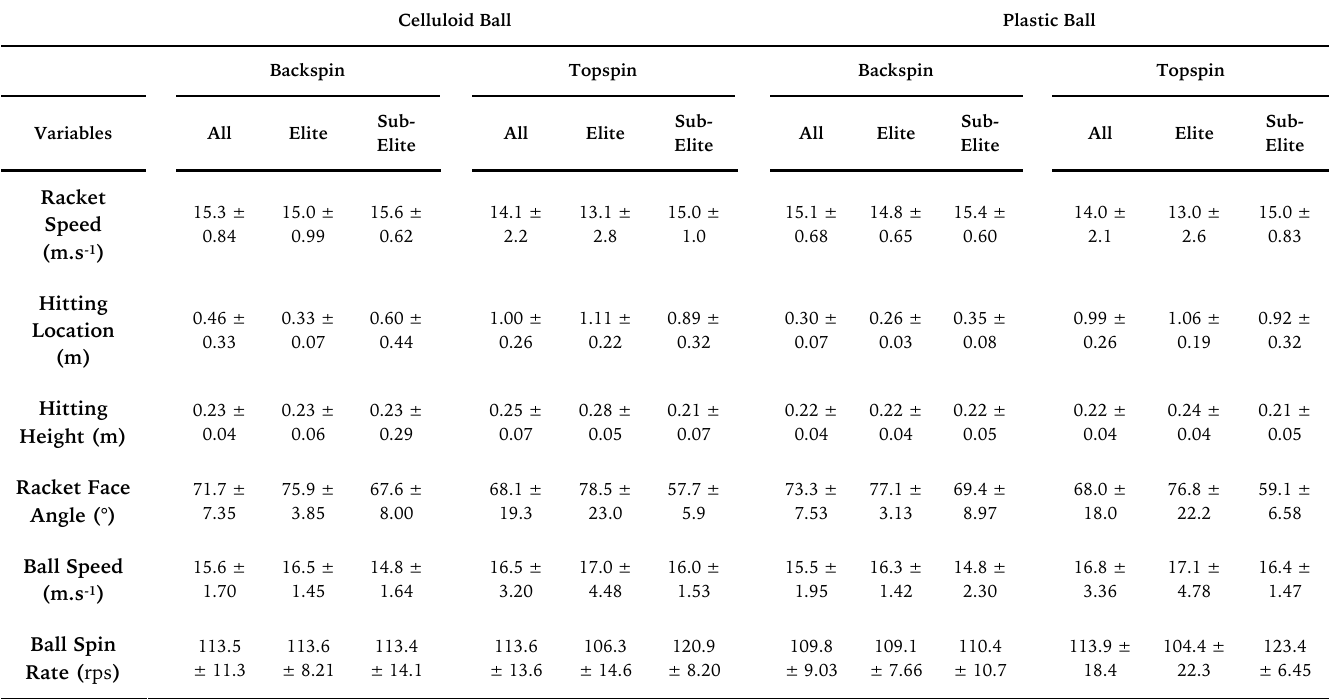
Mean data for variables of forehand